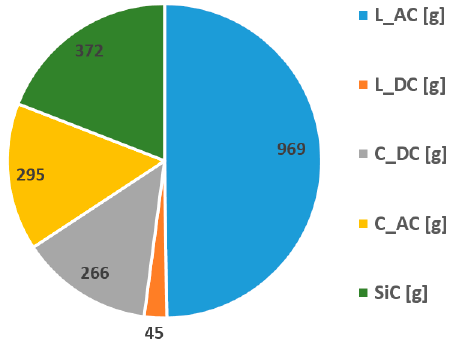
Figure 10. Optimal repartition of the weight for the powder core solution at 97.8% efficiency.